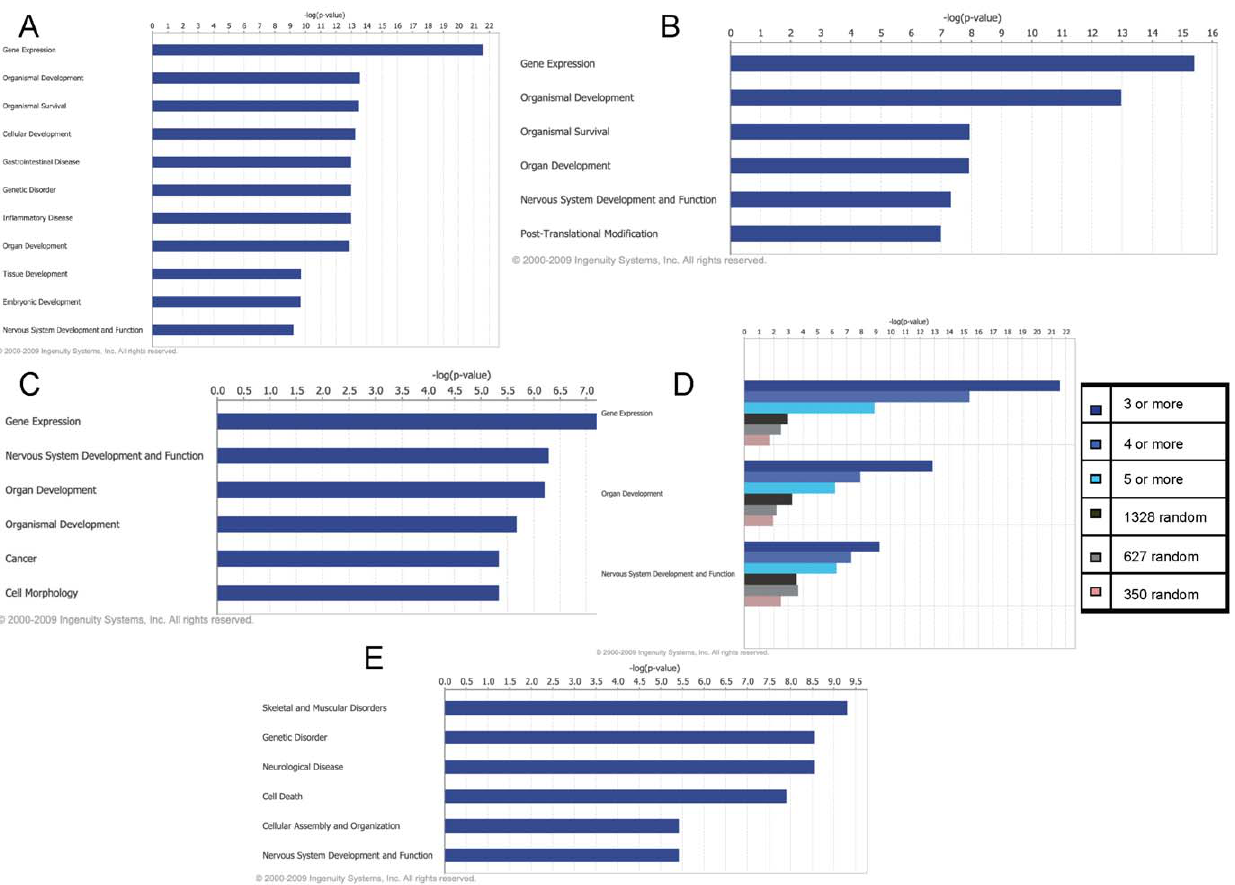
Figure 4. Ingenuity Pathway Core Analysis functions. Analysis of gene transcripts which had three-or-more (Panel A), four-or-more (Panel B) and five-or-more (Panel C), predicted 63-set target sites and a TargetScan context score above the 60 th percentile shown. The listed functions under the graphics are from the category called ‘‘Nervous System Development and Function.’’ The functions are sorted by p -value and only rows having 10 or more molecules are shown. Controls (Panel D) of randomly chosen gene sets of comparable sizes to the five-, four-, and three-or-more gene sets were also run through Ingenuity Pathway Core Analysis and appear in this Analysis Comparison. Only the top three broad categories are shown and they are sorted by the five-or-more order of functions. Overlap (Panel E) between the L4 ipsi- vs. contralateral mRNA transcripts and predicted mRNA targets of 63-set miRNA (60 th percentile) were run through Ingenuity Pathway Core Analysis. The top six functional categories are shown and the sub- categories under ‘‘Nervous System Development and Function’’ are listed, sorted by p -value and only rows having 10 or more molecules are